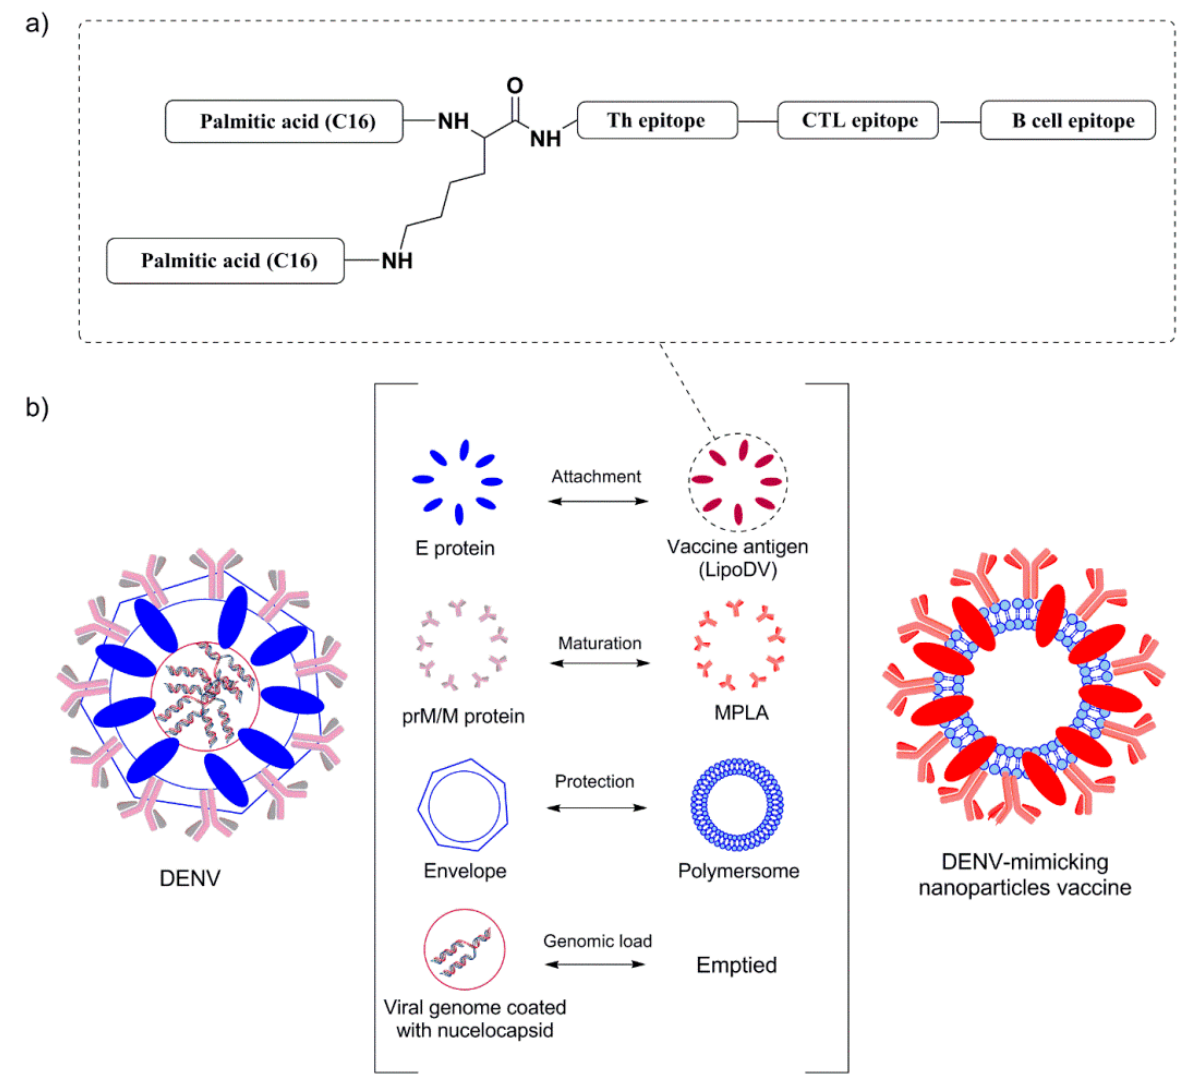
Figure 1. ( a ) A schematic diagram of the LipoDV as a dengue vaccine antigen. LipoDV featured a linear polypeptide consisting of B cell (E 383 − 397aa : EPGQLKLNWFKKGSS), T cell (E 345 − 359aa : RHVLGRLITVNPIVT) and Th (E 352 − 368aa : LITVNPIVTEKDSPVNIE) epitopes bearing two copies of palmitic acid (C16) attached through the N-terminus and the sidechain of lysine. ( b ) Idealized structural representation of the DENV-mimicking nanoparticle platform technology.